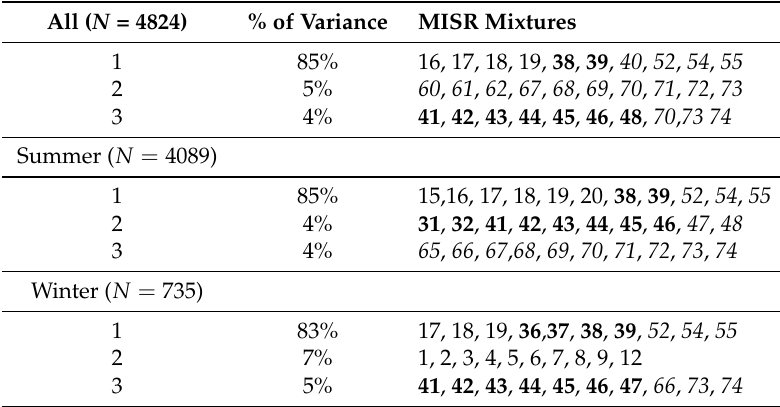
Figure 3. Validation of AERONET AOD interpolated to 550 nm versus MISR AOD ( left ) and MISR AOD_raw ( right ) with 1-to-1 line and expected error (EE) envelope. Table 2. MISR mixtures with largest contributions to the top three principal components. Normal text indicates spherical, non-absorbing particles; bold indicates spherical, absorbing particles; and italics indicates nonspherical